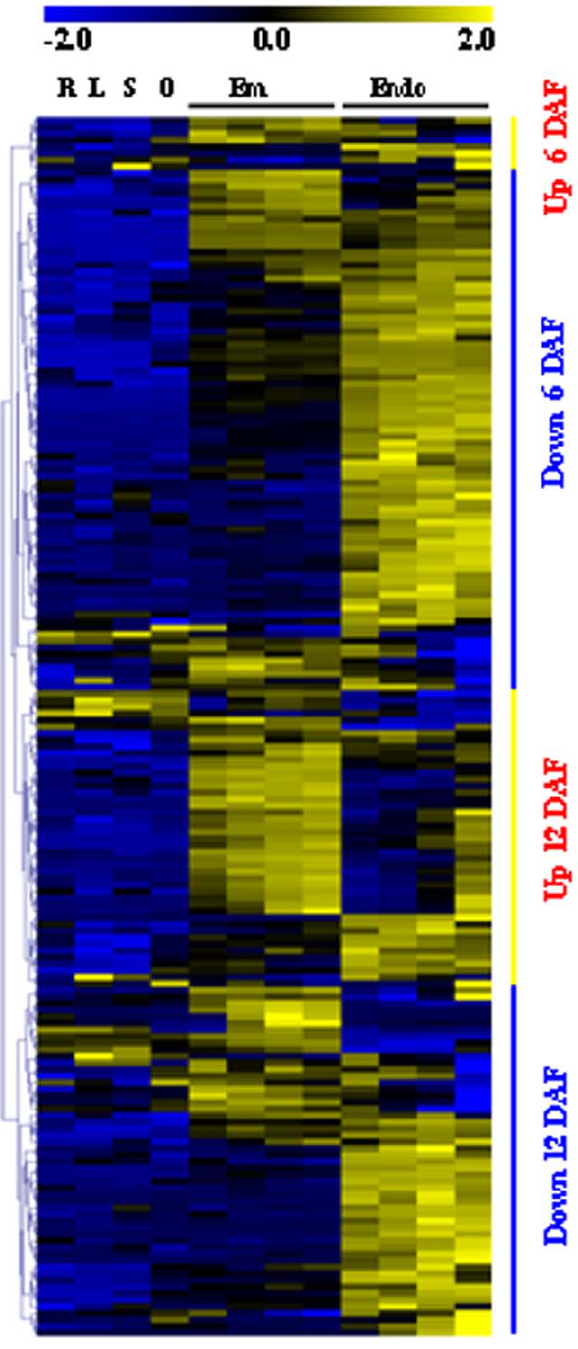
Figure 9. Expression patterns of seed development associated genes regulated by low temperature. The vertical bar indicated the pattern of genes regulated by cold in Zhonghua 11(ZH) seeds. Heat map showed the expression pattern during embryo (Em) and endosperm (Endo) development and in root (R), leaf (L), seedling (S) and ovary (O). The data were normalized using Z score as indicated in the scale bar.